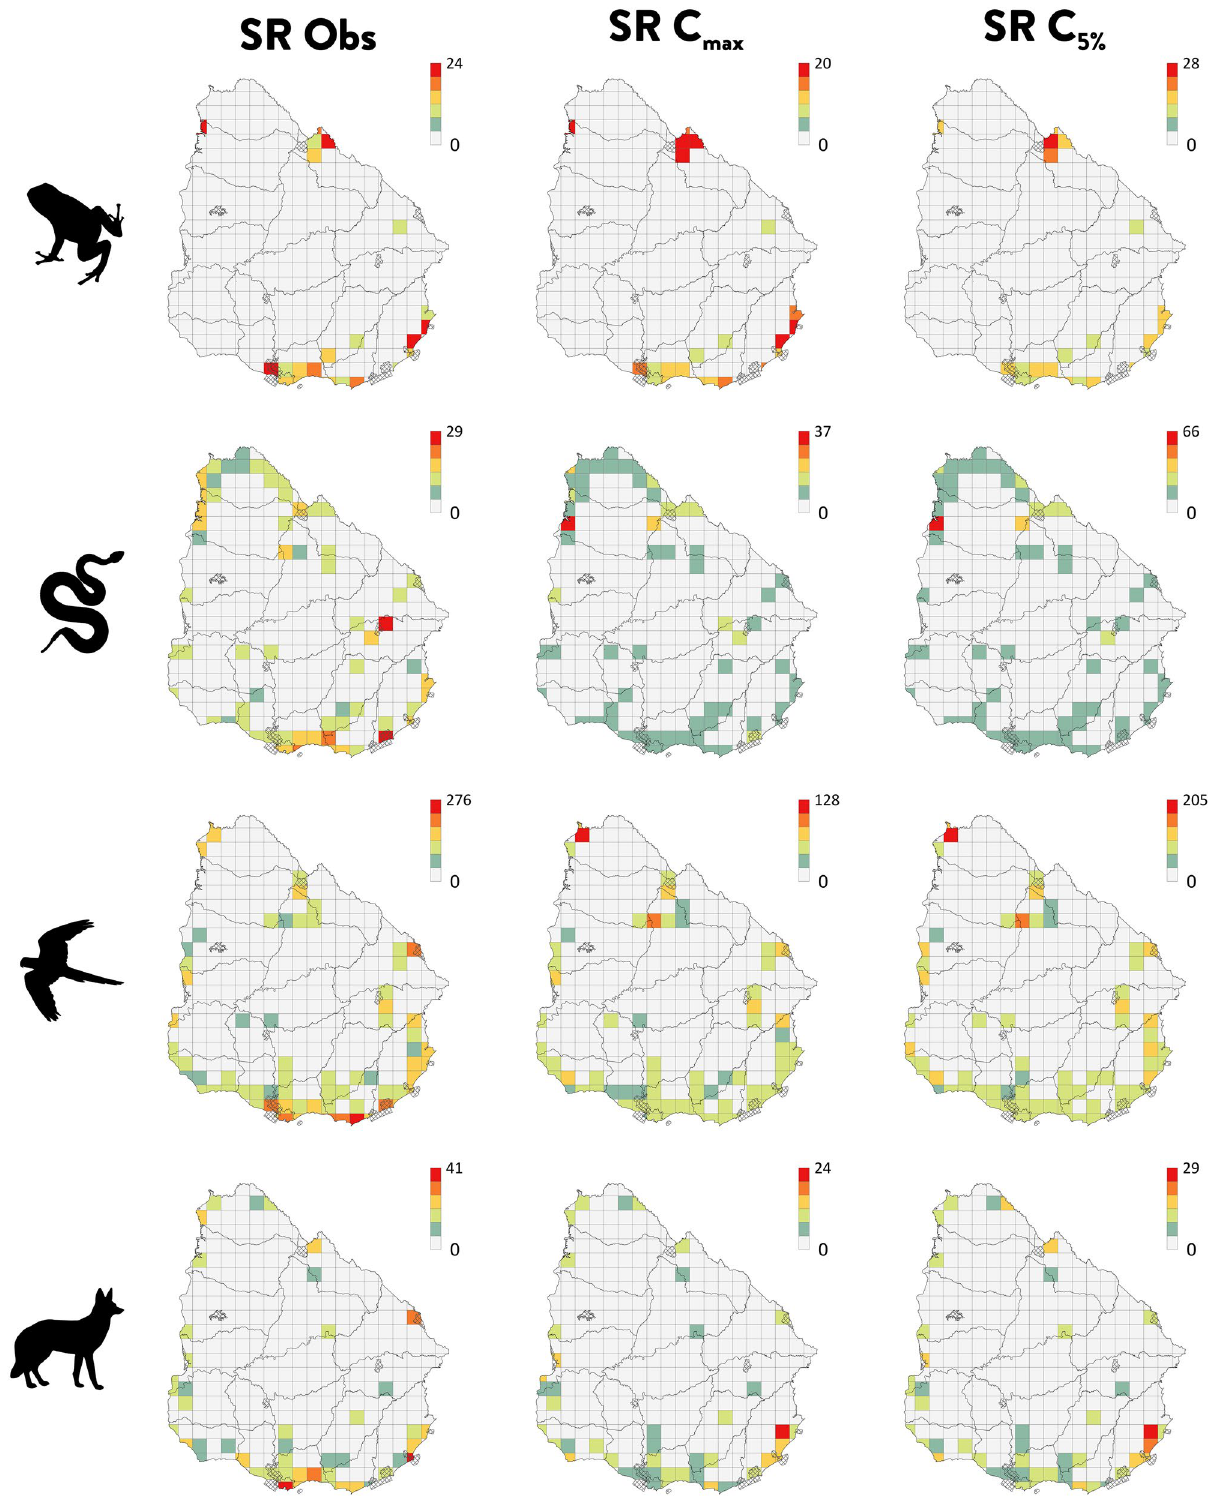
Figure 3. Spatial patterns of observed and estimated species-richness (Hill’s number of order q = 0) for tetrapods in Uruguay. Observed species-richness, species-richness at C max (minimum coverage of samples extrapolated to double the size of the reference sample) and at C 5% (5% percentile of sampling coverage at doubled sample sizes), for amphibians, reptiles, birds and mammals. Protected areas are shown overlapped. All maps in 25 × 25 km grid-cell resolution. Projection WGS1984. Maps generated using ArcGIS 10.6 (https ://deskt op.arcgi